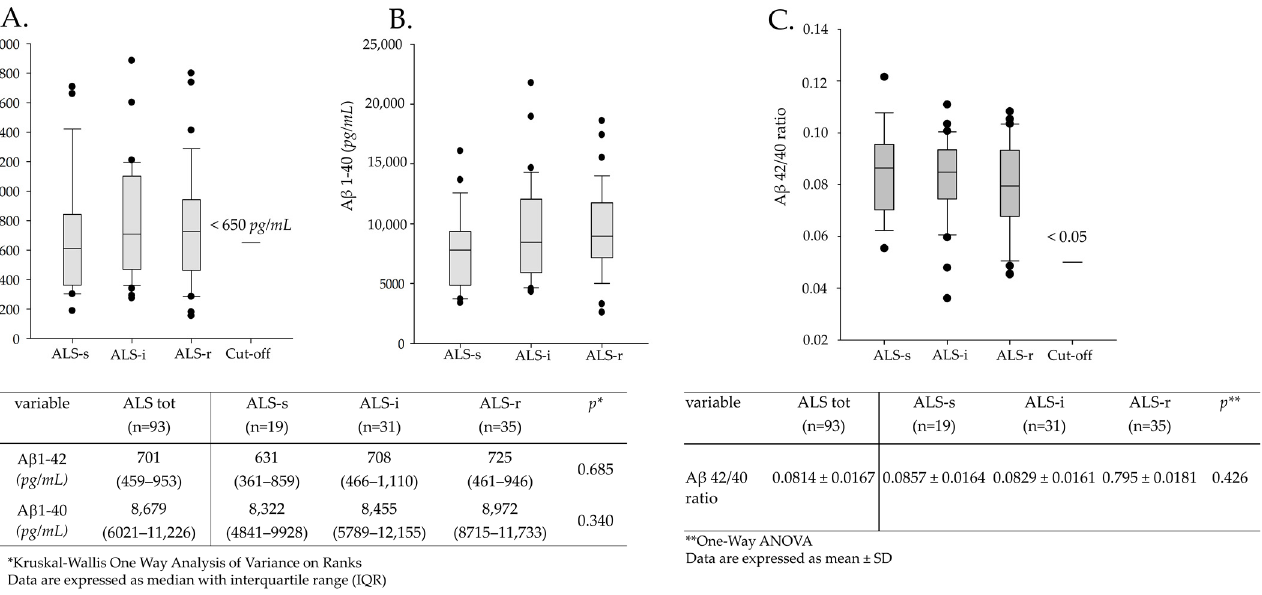
Figure 1. Cerebrospinal fluid (CSF) A β levels in ALS patients and in patients with slow (ALS-s), intermediate (ALS-i) and rapid (ALS-r) progression. ( A ) A β 1–42; ( B ) A β 1–40, ( C ) A β 42/40 ratio. Solid dots in A–C represent known outliers.